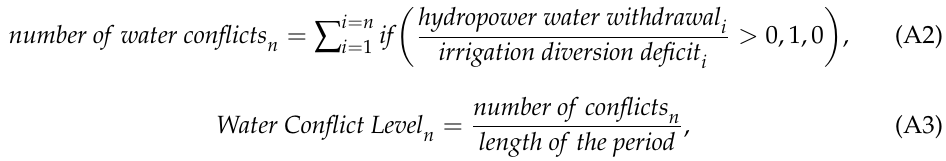
( c ) Figure A2. Fractions of instream flow, hydropower water withdrawal, and irrigation diversion over total allocated water.